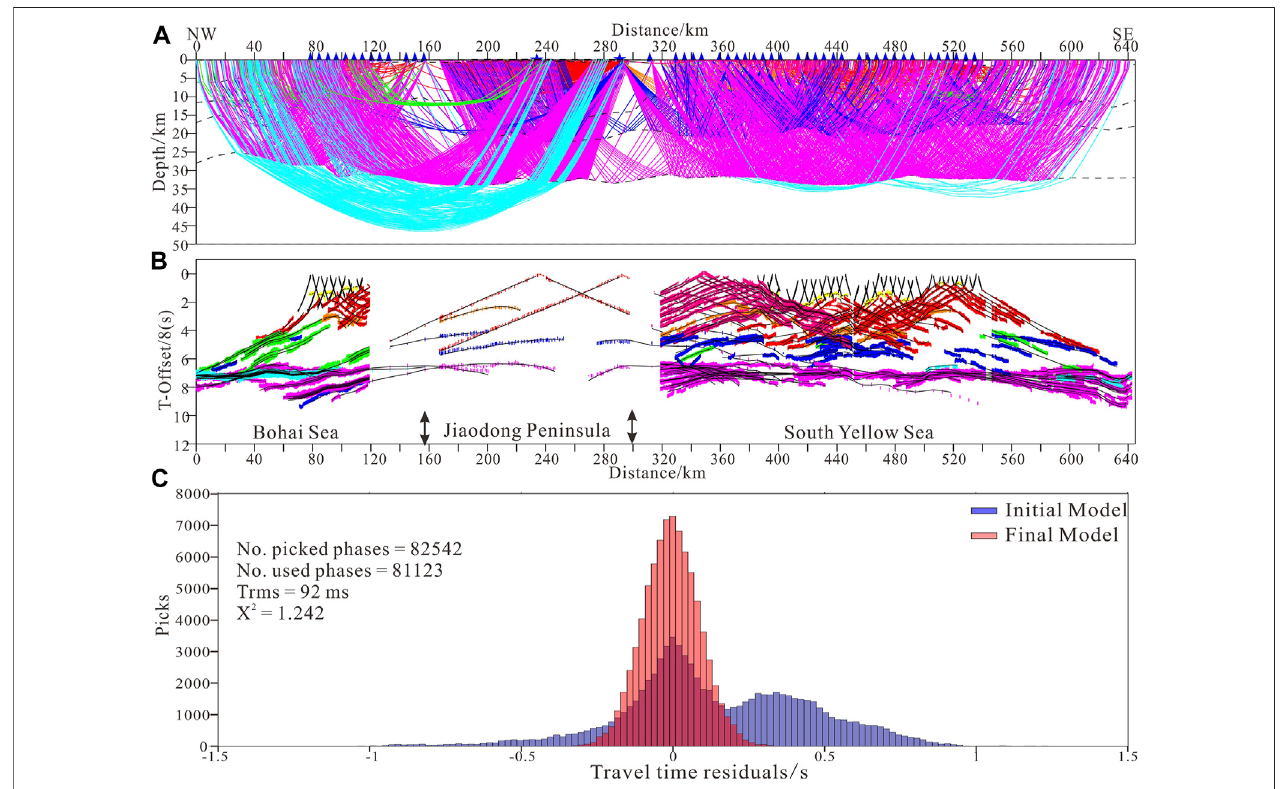
FIGURE 6| (A) Ray paths ofall phases from the sources to the receivers ofLine 2013. The blue triangles on the top are useful OBSs and land stations, and only 1/ 50 of the air gun ray paths are displayed. (B) Observed traveltimes (colored short vertical lines, whose length are corresponding to picking uncertainties) and calculated traveltimes(blacksolidlines)forallstationsofLine2013. (C) Traveltimeresidualdistributionoftheinitialmodel(bluehistogramintherear)andthe fi nialforwardmodel(red histogram in the front).